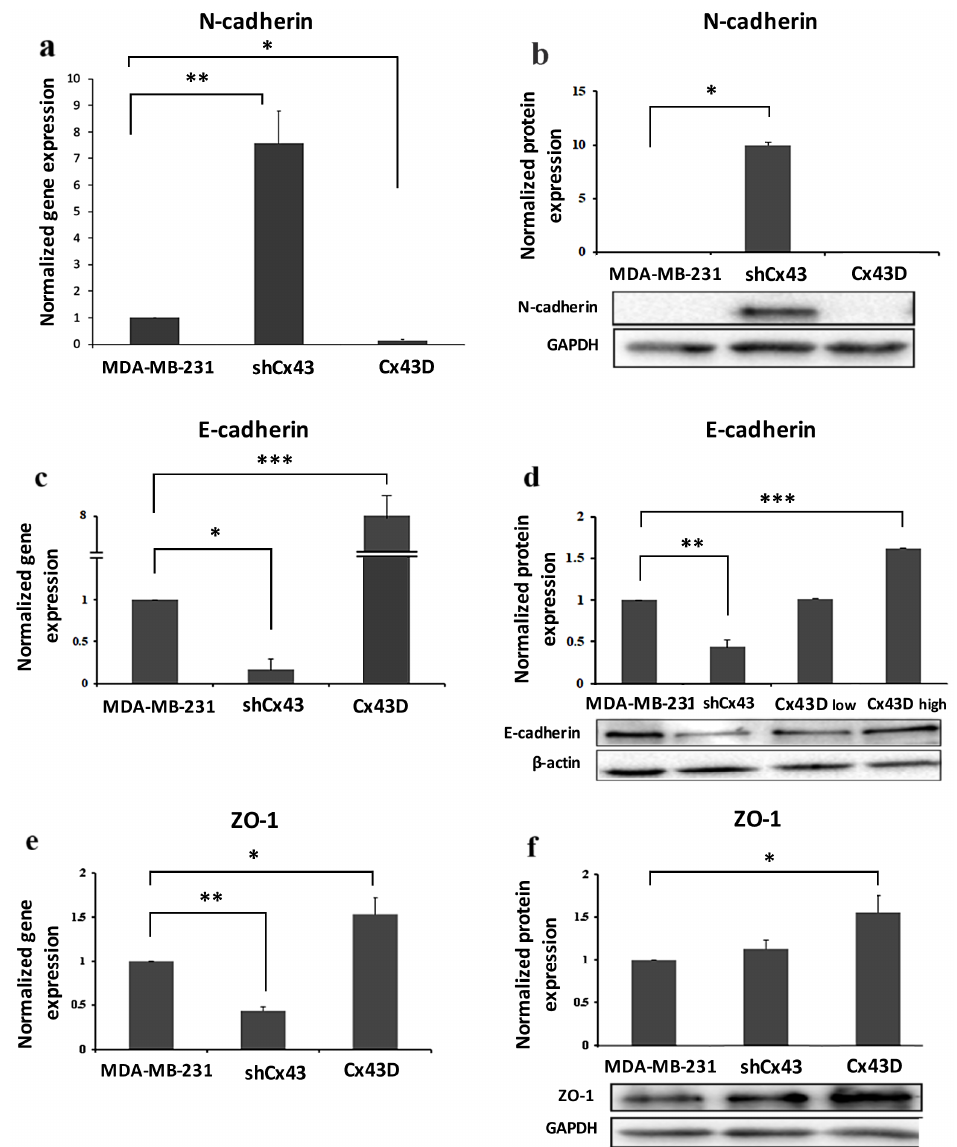
Figure 3. Cx43 overexpression decreases the expression of EMT markers. ( a , c , e ) Bar graph displaying N-cadherin, E-cadherin and ZO-1 mRNA expression levels in MDA-MB-231, shCx43 and Cx43D cells, as detected by qPCR and normalized to GAPDH. Results are representative of two independent experiments. ( b , d , f ) Western blots of N-cadherin, E-cadherin and ZO-1 protein expression in MDA-MB-231 cells, shCx43 and Cx43D cells, with densitometry analysis after normalization to GAPDH (or β -actin). Panel ( d ) also displays western blotting data of E-cadherin protein levels in Cx43D (low) and Cx43D (high). Results are representative of two independent experiments. * p < 0.05; ** p < 0.01; *** p <